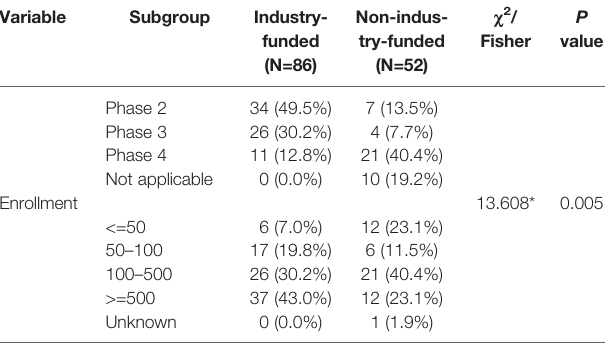
TABLE 3 | Characteristics and study design of trials according to the primary funding